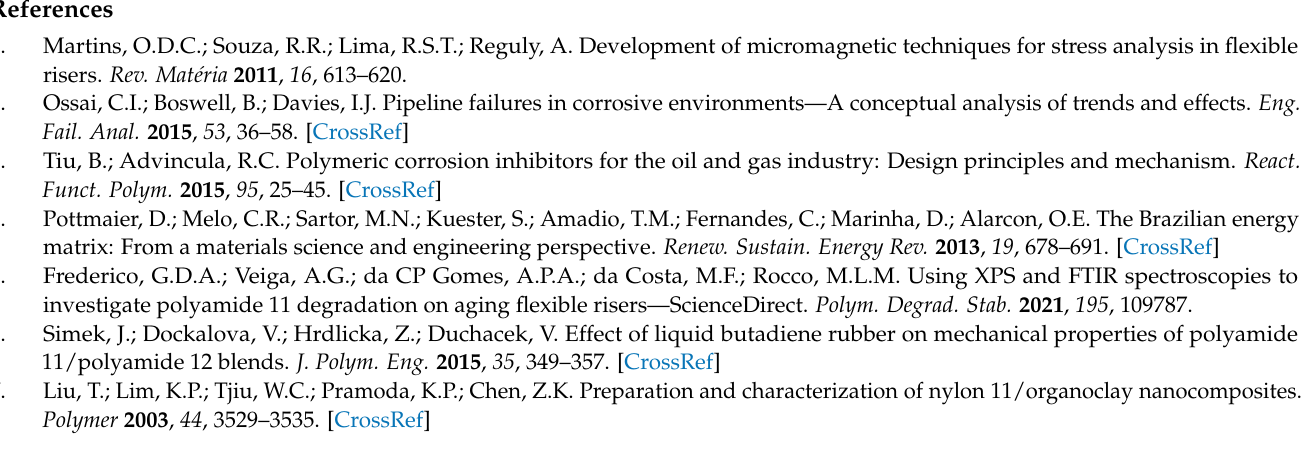
coefficients of CO 2 in PA11/SiO 2 composite, Permeability versus reciprocal temperature; Figure S2: Temperature influence on transport coefficients of CO 2 in PA11/SiO 2 composite, diffusion versus reciprocal temperature; Figure S3: Permeability coefficient, diffusion coefficient, and solubility of CO 2 in PA11 vary with temperature; Figure S4: Permeation curve of PA11 at 20 ◦ C, 30 ◦ C, 50 ◦ C, 70 ◦ C, and 90 ◦ C, diagram of free volume with temperature; Table S1: Intercept and slope of permeability– temperature fitting curve; Table S2: Intercept and slope of diffusion–temperature fitting